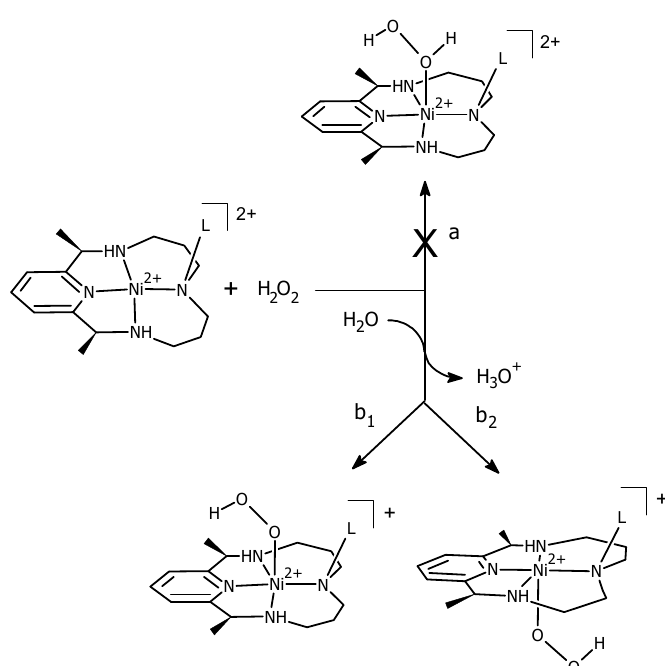
3 4 Figure 3. General representation of Ni(II)–PyMAC complex. Nitrogen atoms are numbered accordingly. L stands for the part of the pendant arm that coordinates axially to the Ni metal center. 3.2. H 2 O 2 Activation and Reactivity with Ni(II)–PyMACs The binding of H 2 O 2 to the complex is a crucial step in the catalytic process of Ni(II)–PyMACs. Two possible fates of H 2 O 2 (Scheme 3) were investigated: (a) straightforward coordination to Ni via linkage to one of its two oxygen atoms to form [(L)Ni 2+ –HOOH] 2+ ; and (b 1/2 ) deprotonation by a base to generate HOO − , which will eventually bind to the complex to form [(L)Ni 2+ –OOH] + . To determine the more plausible form of the first intermediate (INTMD1), complex 4 was studied as the model catalyst. The optimization of high ‐ spin ( S = 1) [(LMe)Ni 2+ –HOOH] 2+ and [(LMe)Ni 2+ –OOH] + revealed that pathway (a) is less likely to be the first reaction step regardless if it is in the gas phase or in solution. For [(LMe)Ni 2+ –HOOH] 2+ , the coordinate covalent bond between O axial and Ni elongated to the extent that it eventually disappeared during optimization. The presence of the